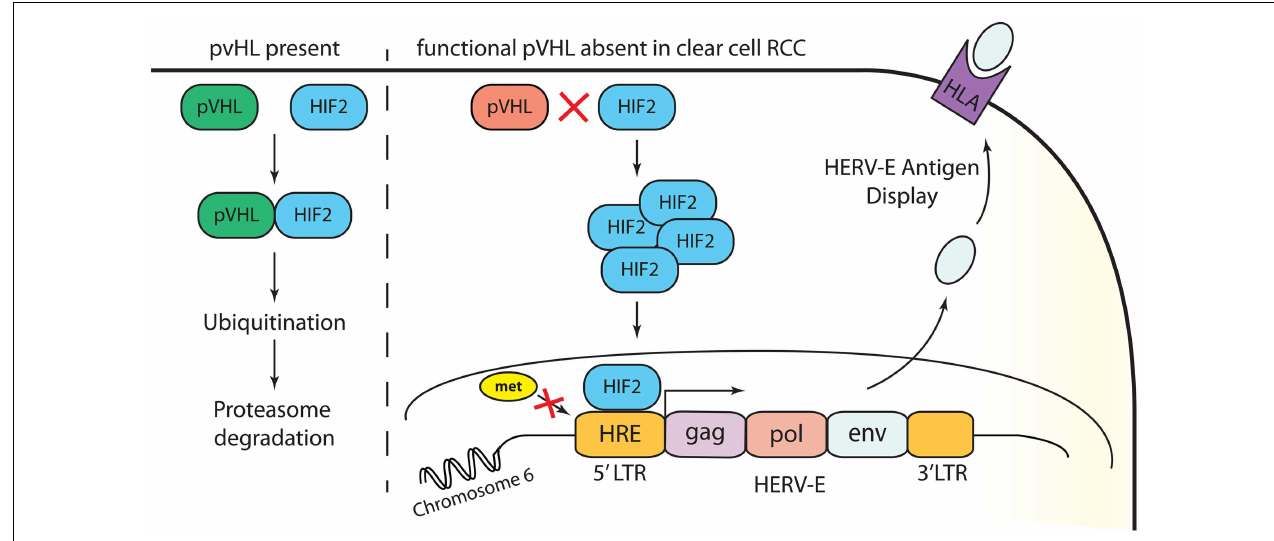
FIGURE 1 |Transcriptional up-regulation of CT-RCC HERV-E in clear cell RCC appears to be a consequence of three events: (i) VHL inactivation, (ii) HIF-2 α overexpression, and (iii) hypomethylation of the HERV-E 5 (cid:48) LTR